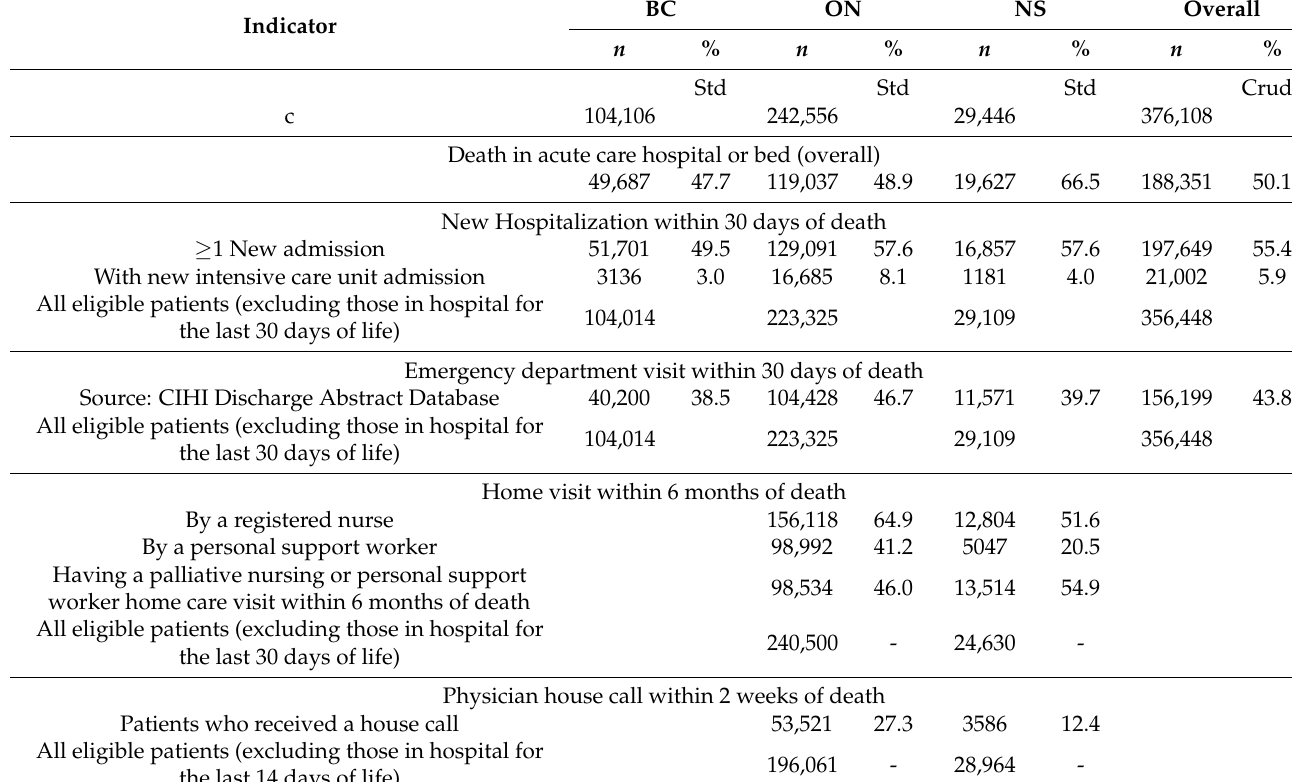
Table A2. Quality indicator rates by province,